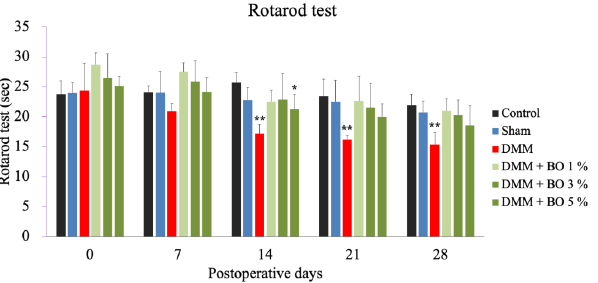
Figure 2. Rotarod test as a locomotive function. Rotarod test was performed prior to surgery, and 7, 14, 21, and 28 days after DMM surgery. * p < 0.05, ** p < 0.01 vs. Control by Dunnett test. BO; Boiogito, DMM; Destabilization of the medial